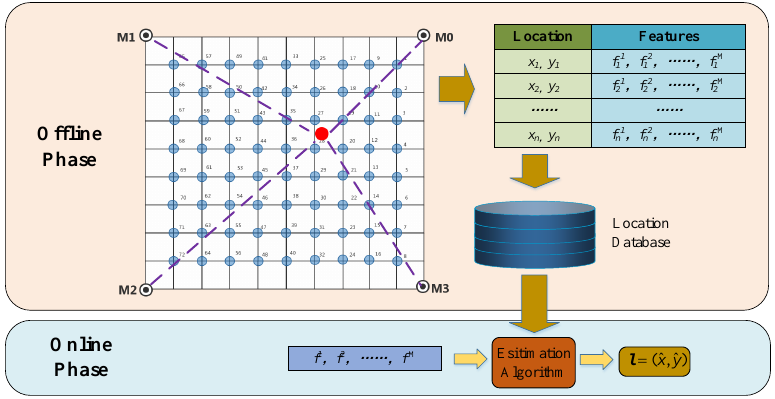
Figure 1. Illustration of fingerprint-based SSL